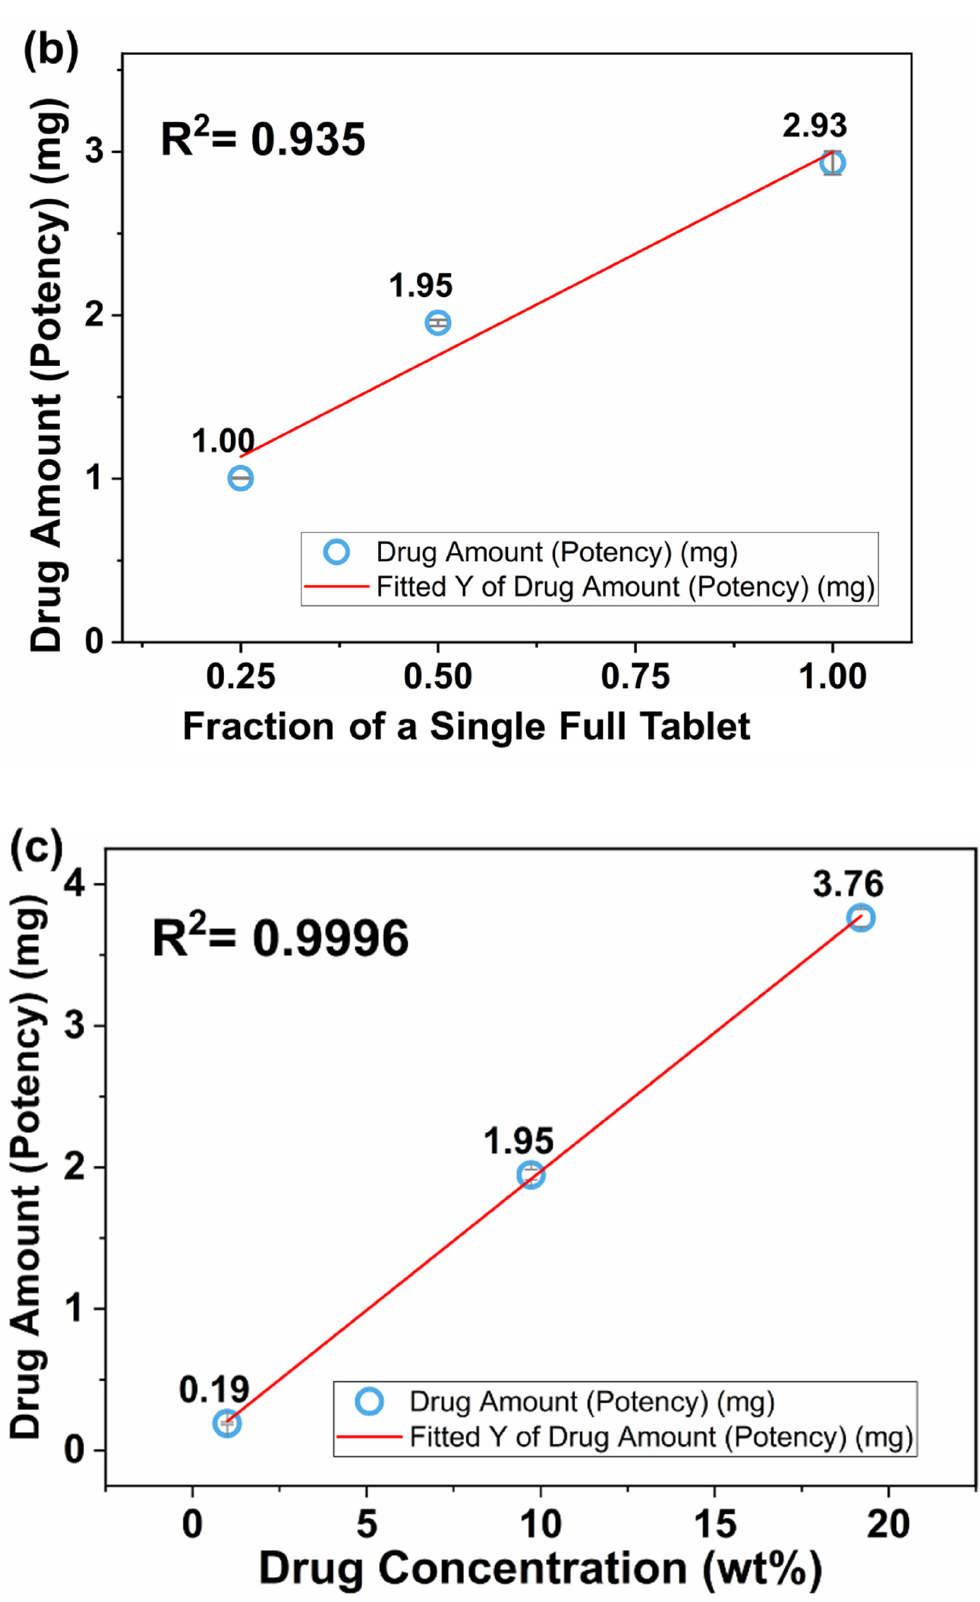
Figure 4. Dose titration via ( a ) multi-unit mini-tablets at 1.0 wt% drug concentration, ( b ) split tablets at 1.0 wt% drug concentration, and ( c ) single unit mini-tablets at 1.0–20.0 wt% drug concentrations.